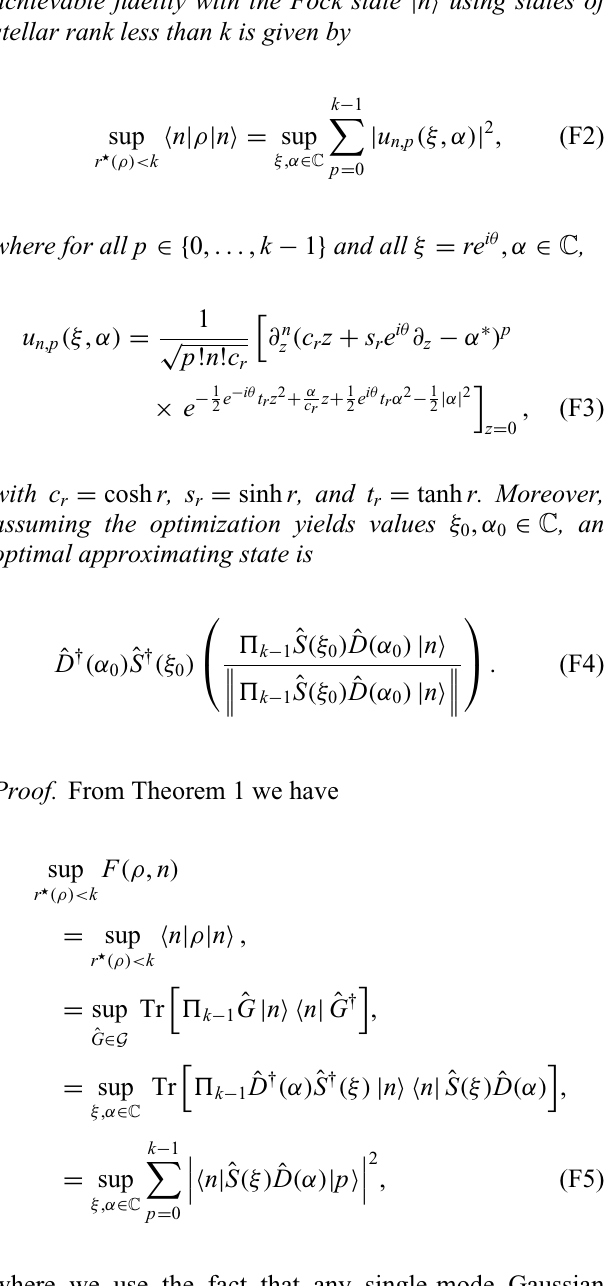
FIG. 7. Achievable fidelities with target core states cos φ | 0 (cid:3) + e i χ sin φ | 1 (cid:3) using Gaussian states, for all φ , χ ∈ [0, 2 π ], as a function of φ